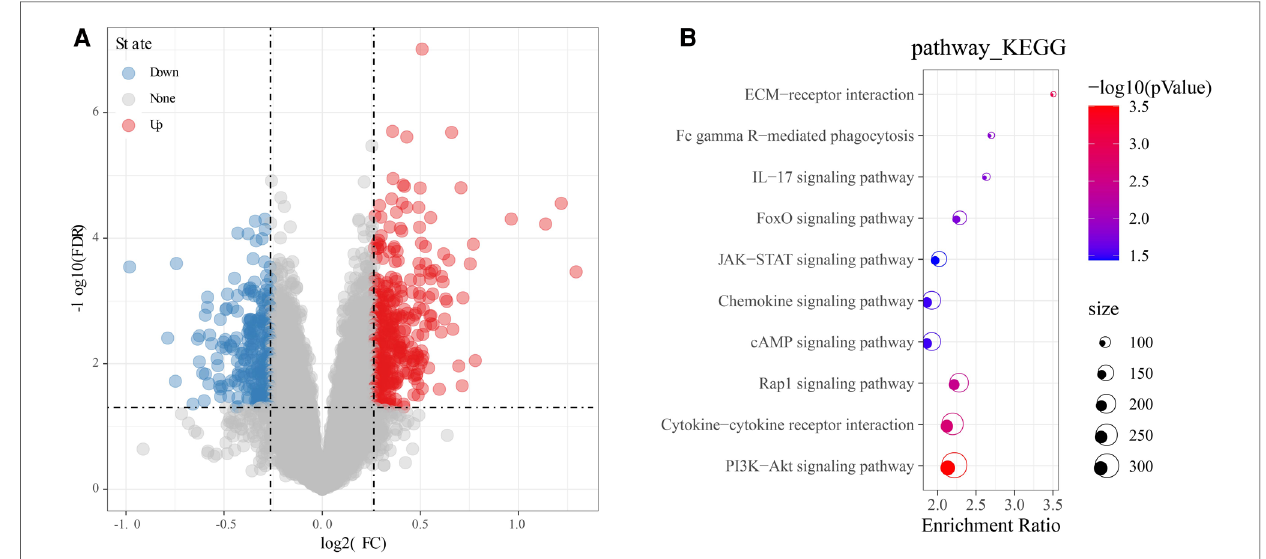
FIGURE 3 Identi fi cation and functional analysis of DEGs. ( A ) Volcano map of DEGs. ( B ) Bubble diagram of KEGG enrichment analysis of DEGs. Red means upregulated genes, and blue means downregulated genes, grey means there was no difference in gene